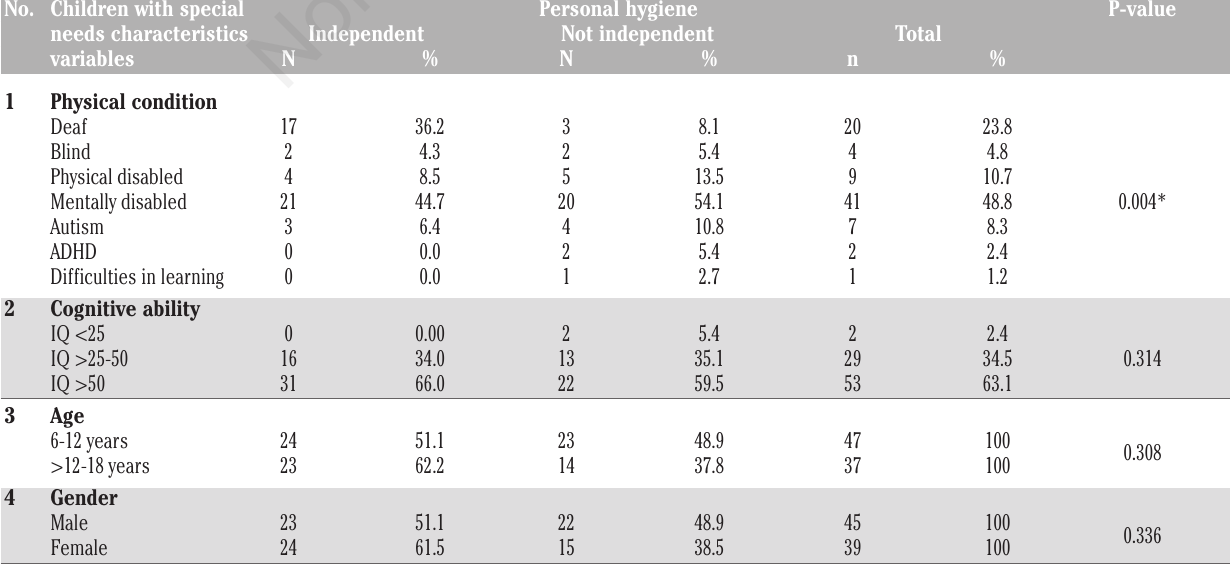
Table 2. Distribution of the relationship characteristics of children with special needs with the ability to maintain personal hygiene in Bogor (n=84). No. Children with